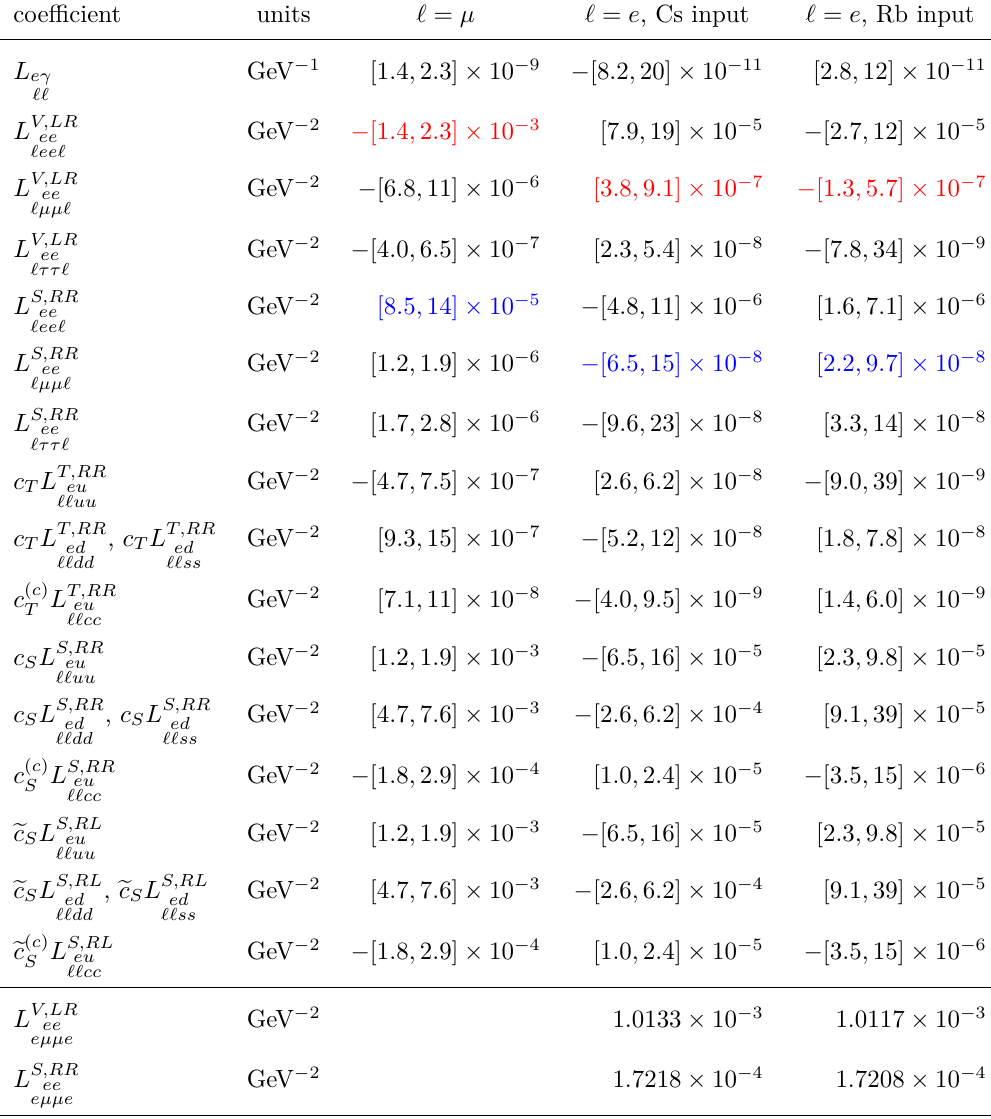
Table 1 . Upper panel: size of single non-vanishing LEFT Wilson coefficients at µ = 2 GeV needed to explain the anomalies ∆ a µ or ∆ a e individually. The ranges correspond to ± 1 σ in eqs. (1.3) and (1.7). The red entries are the same coefficient L V,LR ee = L V,LR ee and the blue entries are the same eµµe µeeµ coefficient L S,RR ee = L S,RR ee , from eq. (2.10). An explanation of the muon anomaly that avoids huge eµµe µeeµ effects in ∆ a e is possible with the combination in the lower panel. A simultaneous explanation of ∆ a e requires a fine-tuning of the two